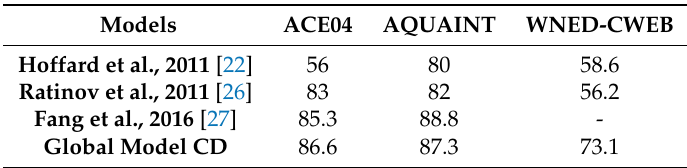
Table 6. Results on other